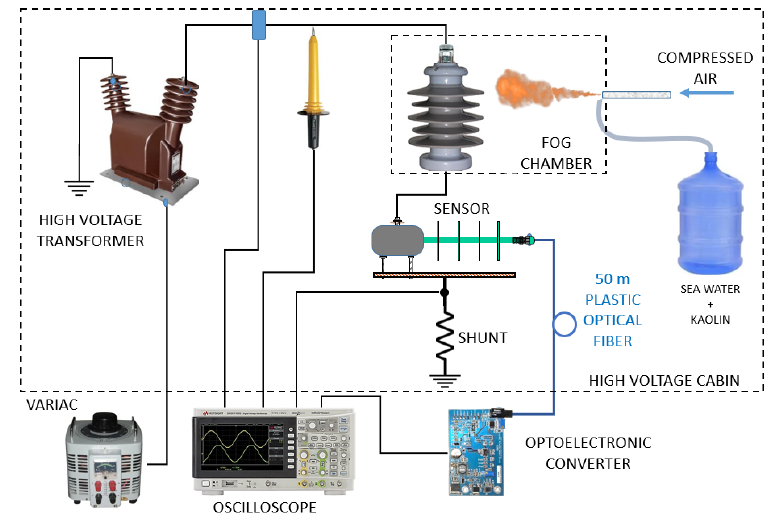
Figure 3. Block diagram of the high-voltage test chamber.